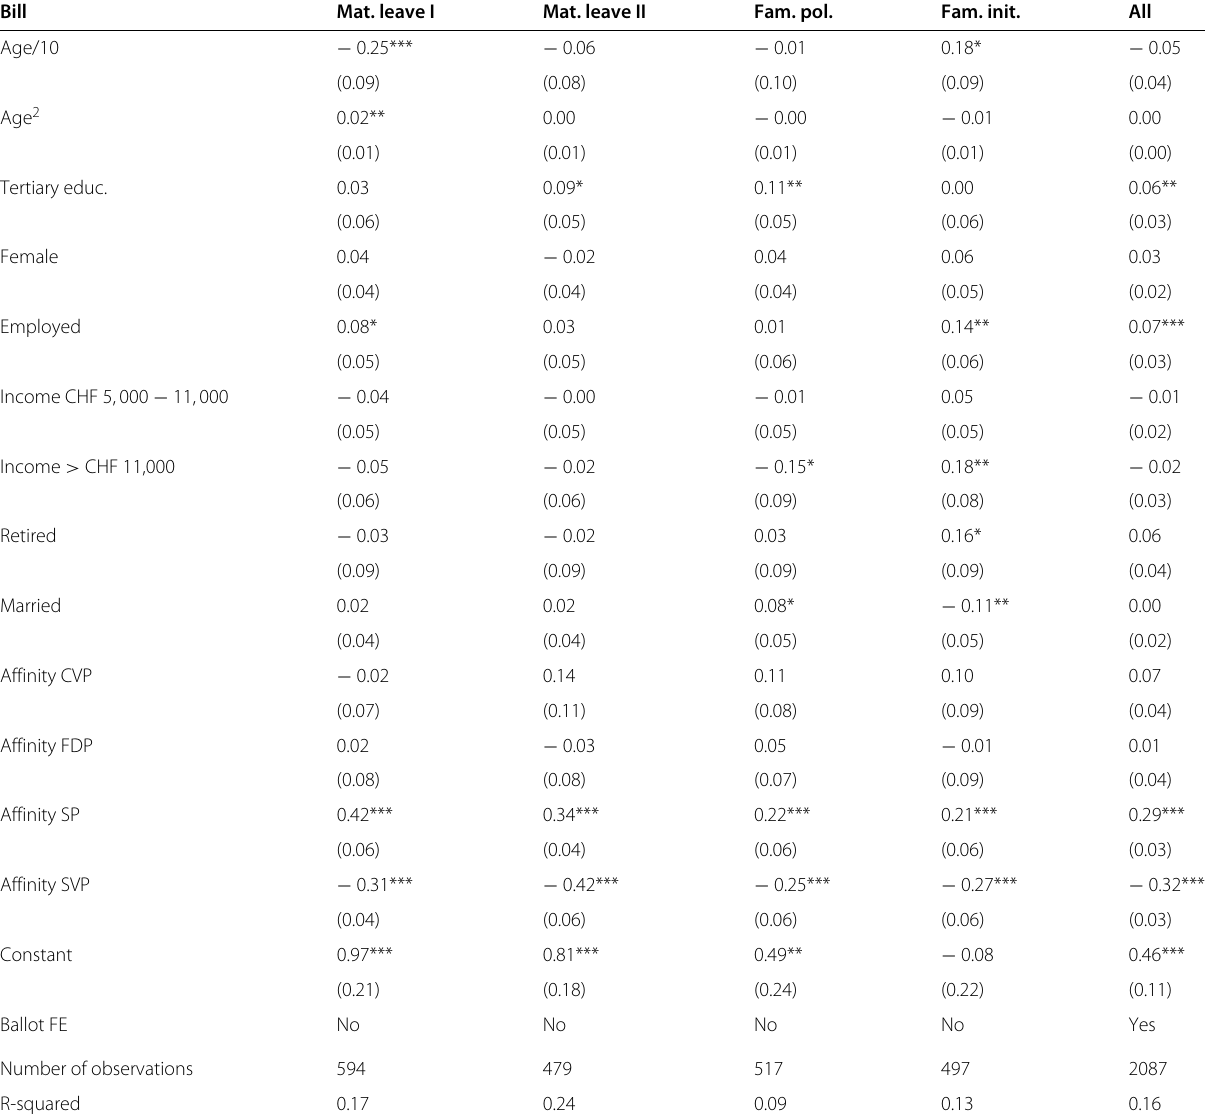
Table 7 Post-vote survey: correlation between the probability to vote yes and certain personal characteristics